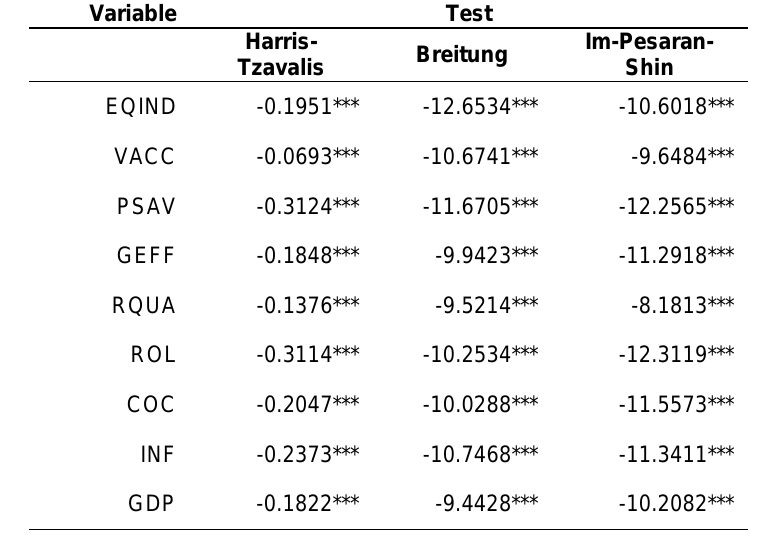
Table 5 . Unit root